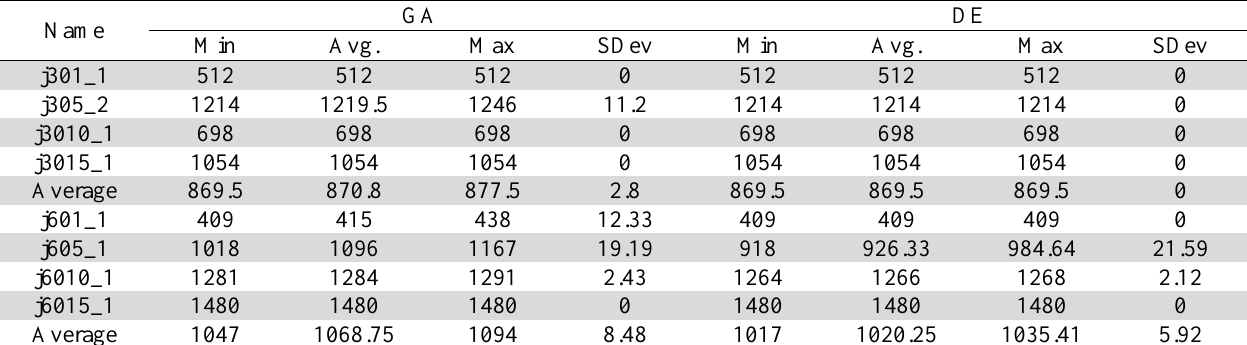
Comparison of performances of GA and DE